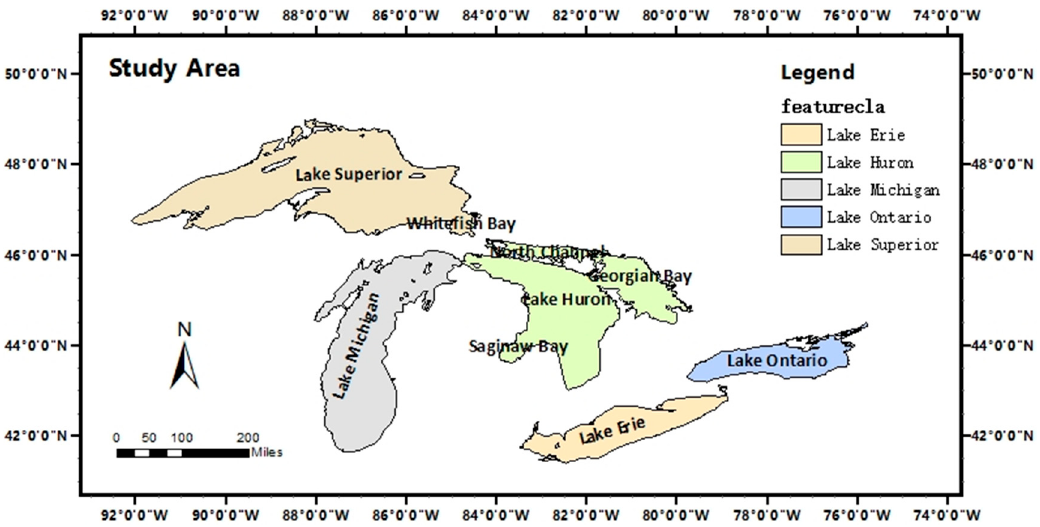
Figure 11. Great lakes study area. Table 2. The number of holes and entities in Scenario A and B .